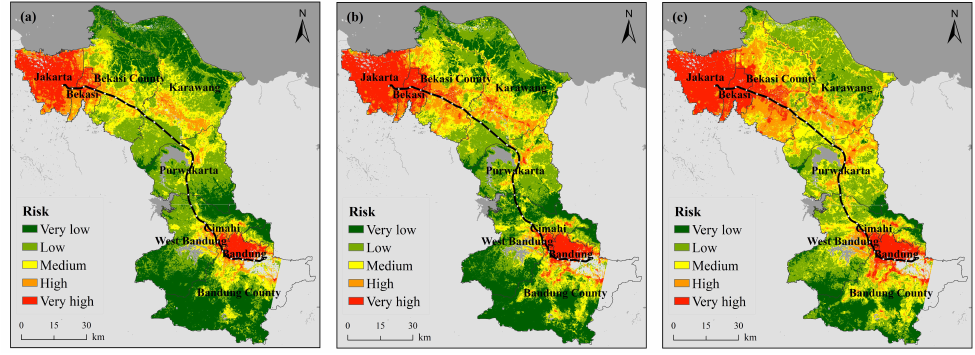
Figure 5. Spatiotemporal variation in the heat wave risk (( a ) 2005, ( b ) 2014, ( c ) 2019). Based on Table A7, all four risk grades notably varied except the low risk level. Among these levels, the very low risk level changed the most, decreasing from 31.16% in 2005 to 11.47% in 2019, a decrease of 19.69% over 15